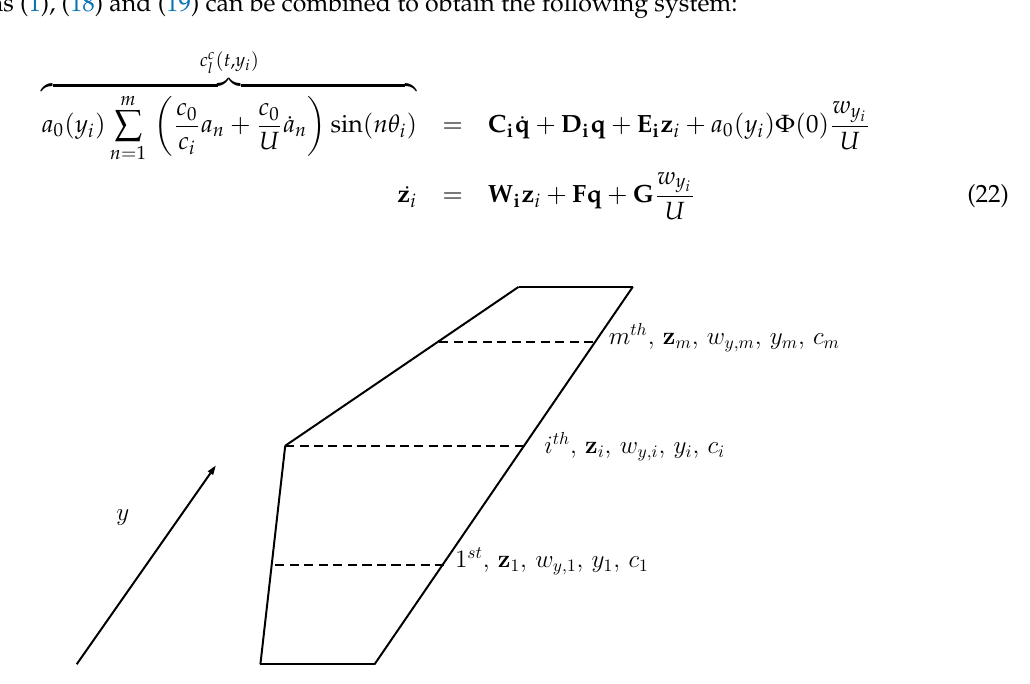
Figure 2. Representation of m strips along the wing span and their respective local